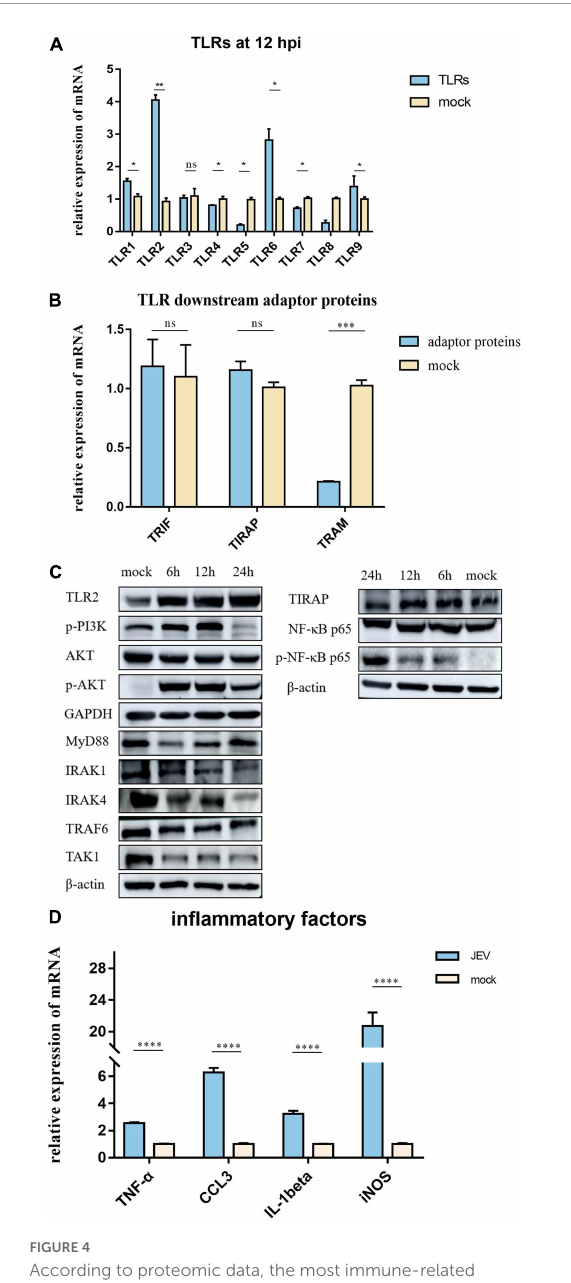
FIGURE4 According to proteomic data, the most immune-related proteins were activated 12 h after infection. (A) Detection of TLR activation by relative mRNA level. TLR2 shows highlight expression in all TLRs; TLR2 was selected for subsequent investigation. (B) To investigate the pathway by which TLR2 exerts functionality, qPCR was performed on critical proteins downstream of TLR2; TRIF, TIRAP, and TRAM were not upregulated. (C) Two pathways downstream of TLR2 were verified by western blotting. The expression levels of PI3K-AKT and NF- κ B pathway proteins were significantly upregulated; however, the MyD88 pathway, which is usually considered a TLR2 junction protein, was not activated. (D) JEV infection promoted the upregulation of inflammatory factors (TNF- α , CCL3, IL-1beta, and iNOS), thus indicating an inflammatory response. All samples were tested in three parallel groups. * P < 0.05, ** P < 0.01, *** P < 0.001, and **** P <